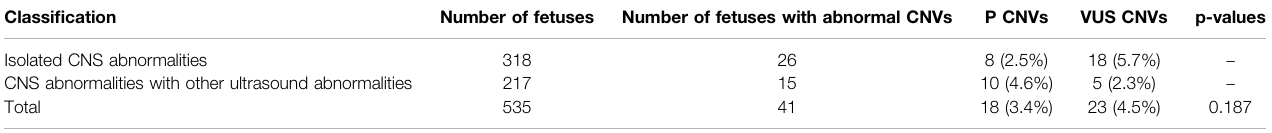
TABLE 5 | The rates of Pathogenic CNVs in isolated CNS abnormalities and CNS abnormalities with other ultrasound abnormalities.